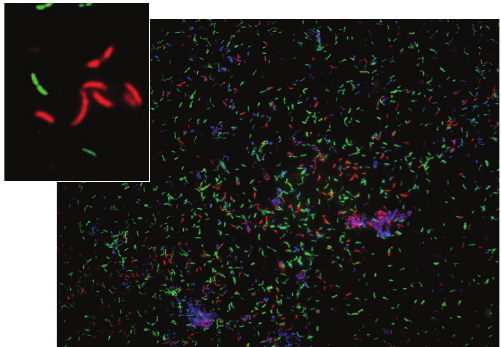
Figure 4: Fluorescence image of vaginal fluid from a subject with BV. Bacteria are shown hybridizing with probes targeting BVAB1 (green) and Mobiluncus (red) and visualized by fluorescence in situ hybridization (FISH). Other bacteria (blue) are seen with 4 (cid:3) ,6- diamidine-2-phenylindole, dihydrochloride, (DAPI), which stains DNA. The inset shows that Mobiluncus (green) is larger than BVAB1 (red) but has the same curved morphology. (With permission from